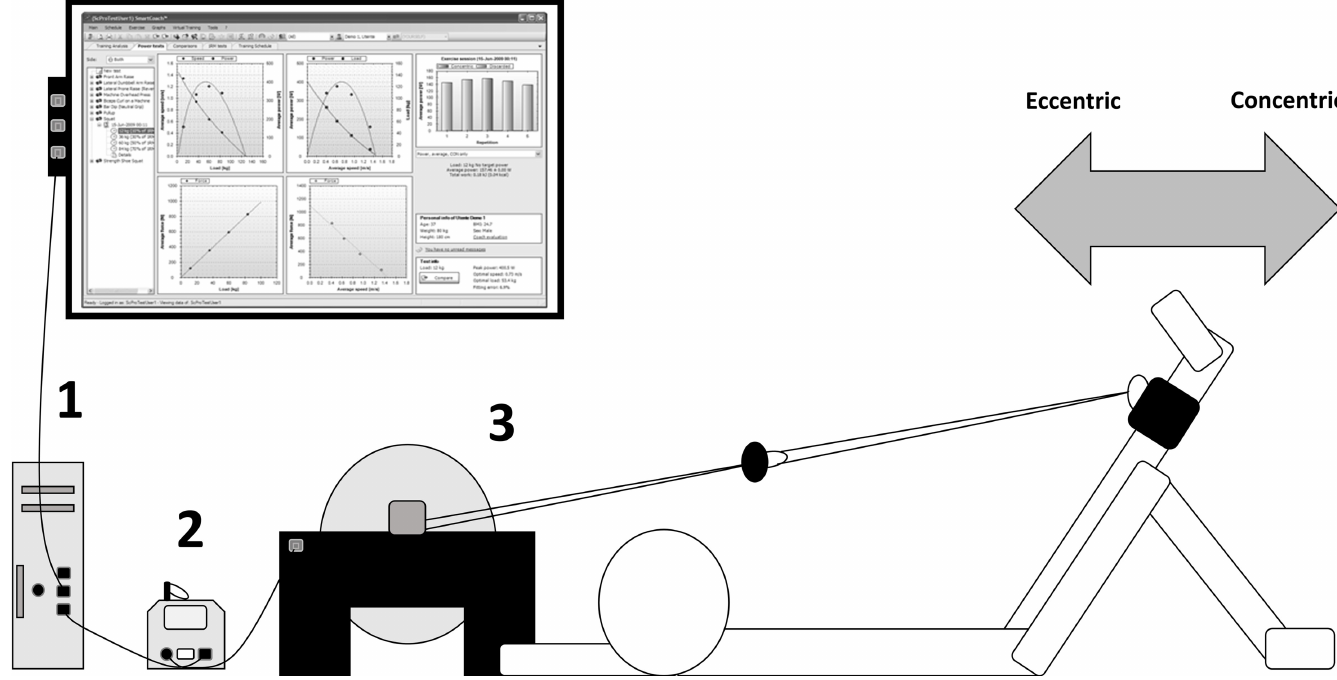
Fig 1. Schematic representation of the hip extension protocol. 1. Software SmartCoach; 2. Sensor SmartCoach; 3. Kbox3.